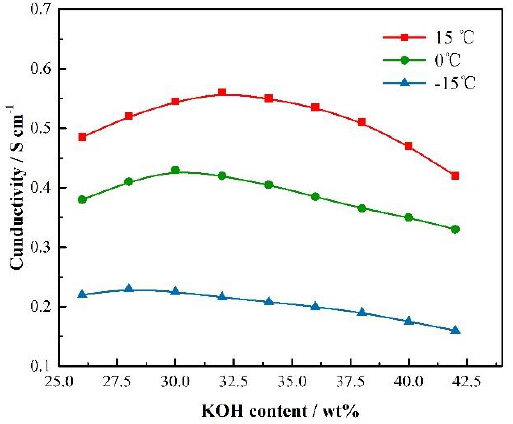
Figure 3. Conductivity curve of KOH at different concentrations and temperatures.